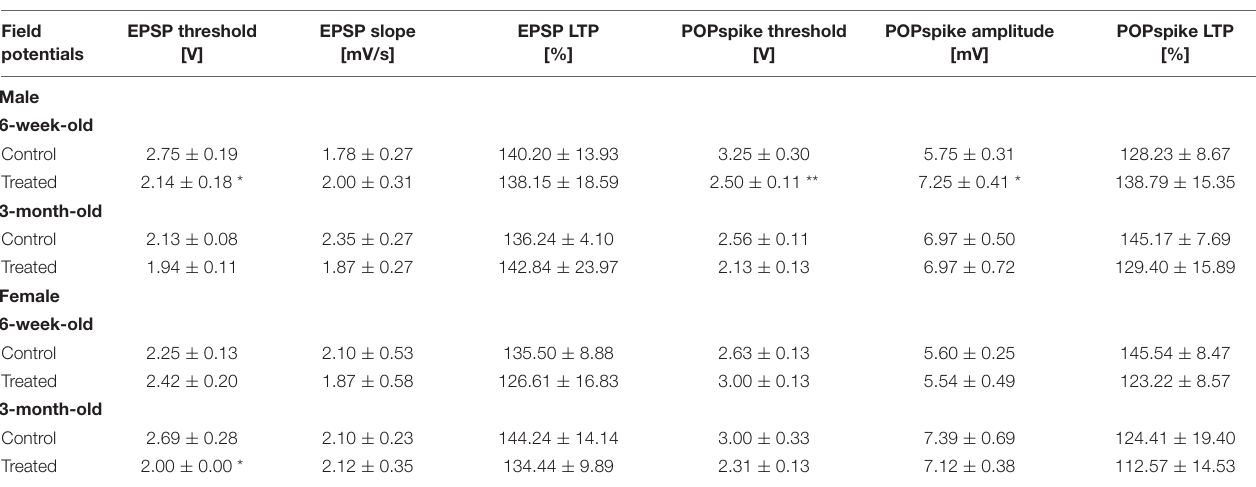
FIGURE 4 | The parameters of spontaneous miniature excitatory postsynaptic currents (EPSCs) of 6-week-old and 3-month-old rats of both sexes exposed to VPA prenatally compared to the control. (A) The median of the amplitudes, (B) the area (charge transfer) and (C) the average frequency of EPSCs in males. (D) The median of the amplitudes, (E) and the area (F) the average frequency of EPSCs in females. Data are expressed as mean and S.E.M. Statistical analysis: one-way ANOVA; * significant difference compared to control group; *: p < 0.05; **: p < 0.01; ***: p < 0.001. TABLE 3 | Parameters of evoked field potentials measured in the CA1 region of HC.